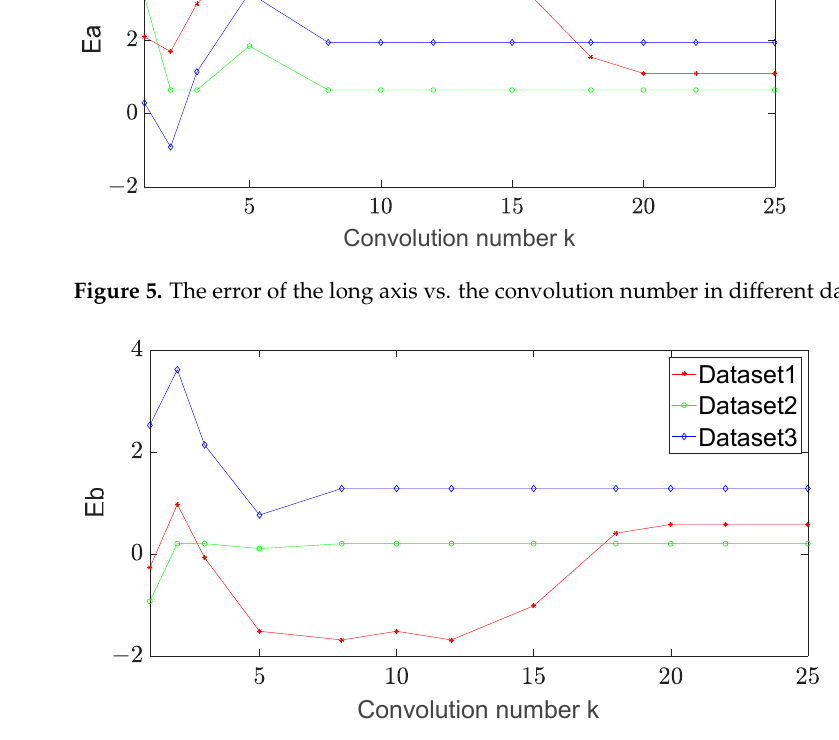
Figure 6. The error of the short axis vs. the convolution number in different datasets.